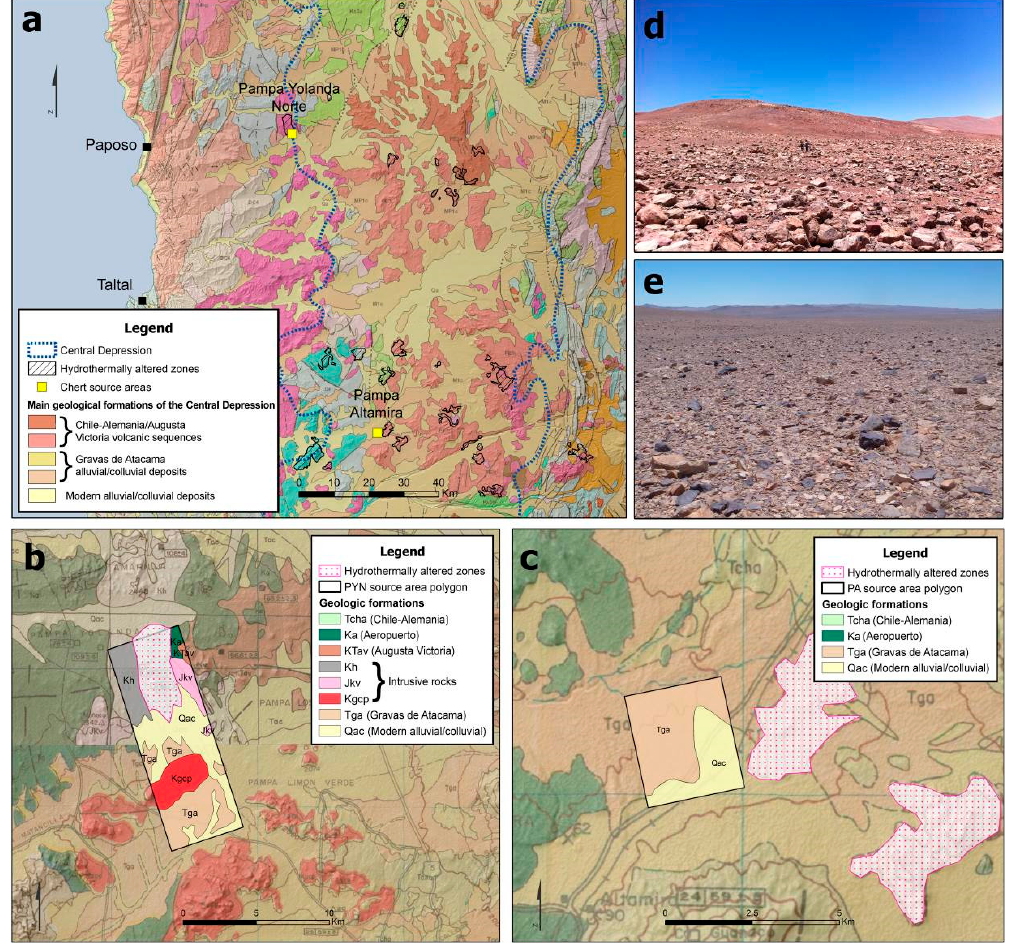
Figure 2. ( a ) Map of the study area showing the main geological formations within the Central Depression (dashed blue lines), hydrothermally-altered zones (black hatched polygons), and chert source areas (yellow squares), data from 1:1,000,000 geological map [82] ; ( b ) and ( c ) source area of Pampa Yolanda Norte ( b ) and Pampa Altamira ( c ), showing associated geological formations and hydrothermally-altered zones (pink dotted polygons), data from 1:250,000 geological maps [80,81]; ( d ) and ( e ) panoramic views of Pampa Yolanda Norte and Pampa Altamira,